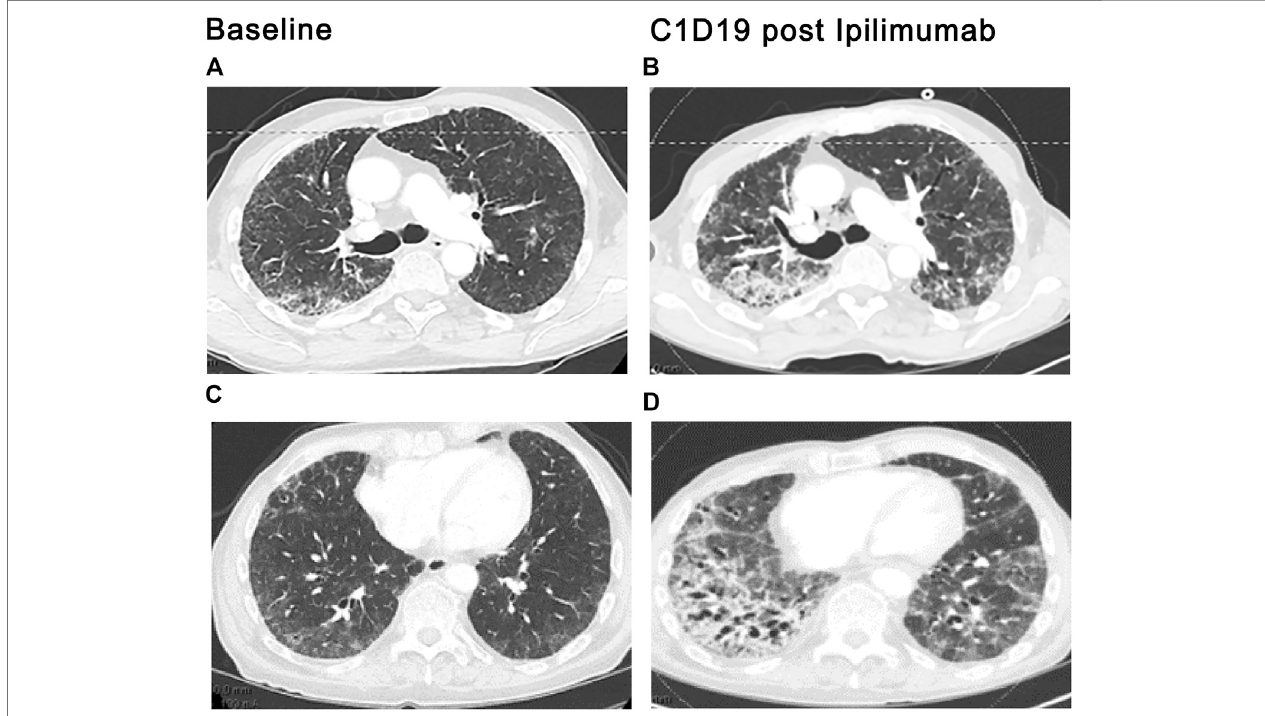
FIGURE 3 | ICI-related sarcoid-like reaction. Diffuse lymphadenopathy in paratracheal, bi-hilar, and mediastinal locations (arrows), (A,C) , developed after the third cycle of ipilimumab plus nivolumab therapy for bladder cancer. Diffuse interstitial and nodular in fi ltrates along bronchovascular bundles (arrows), (B,D) were also seen. Transbronchial biopsies and biopsies of the lymph nodes by endobronchial ultrasound (EBUS) demonstrated noncaseating granulomas. The diagnosis of ICI induced sarcoid-like reaction was con fi rmed once competing diagnoses were excluded.